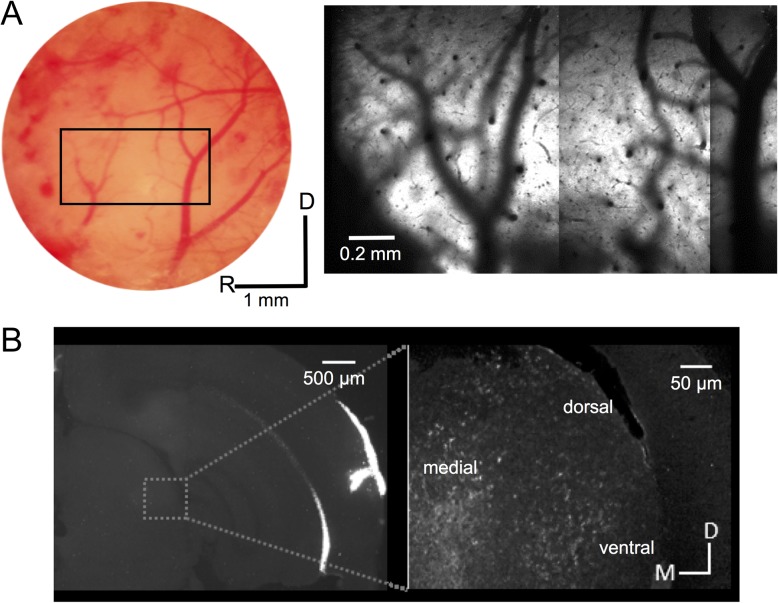
Anatomical confirmation of auditory cortex targeting. (A) A picture of the cortical surface of one mouse, showing the areas were A1 and AAF are located. The detail shows a widefield 2-photon image of the same area, labeled with GCaMP6m. (B) A coronal section from a mouse in which red fluorescent retrobeads were injected into the auditory cortex following the same coordinates used for GCaMP6m injections. The inset shows labeling in the medial geniculate body at higher magnification. The locations of different divisions (dorsal, medial, ventral) are indicated. D, dorsal; M, medial; R, rostral.